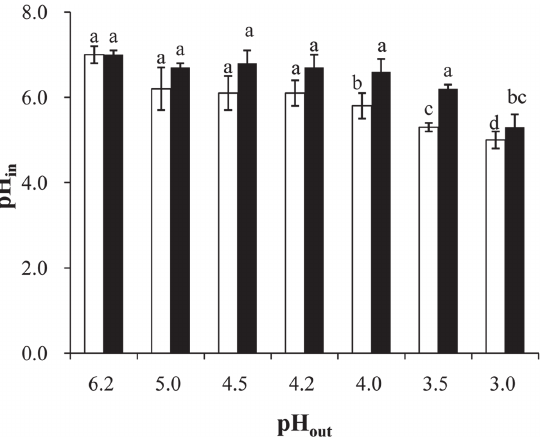
Fig 5. Effect of environmental pH on the intracellular pH in Bifidobacterium . White bars, the control cells; black bars, the pre-stressed cells. The same letters indicate no significant difference among the pH in values in B . longum BBMN68 cells under different environmental conditions ( p > 0.05). Biological repeats, n =